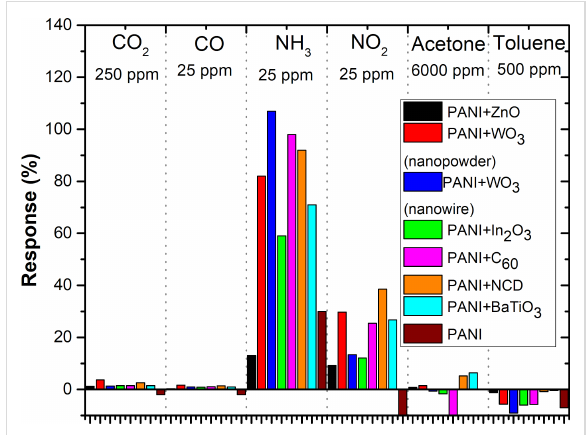
Figure 9: The summary of the gas sensor responses for all active layers.